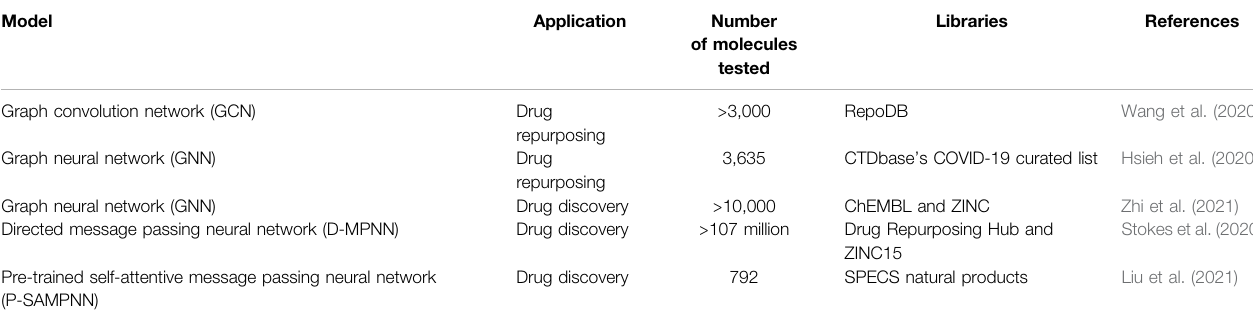
TABLE 2 | Recent GNN applications in